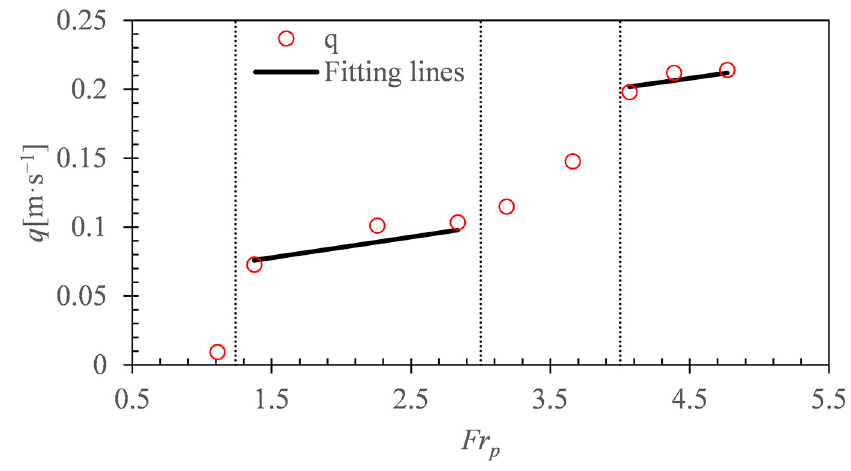
Figure 15. The relationship between turbulent kinetic energy and Fr p.